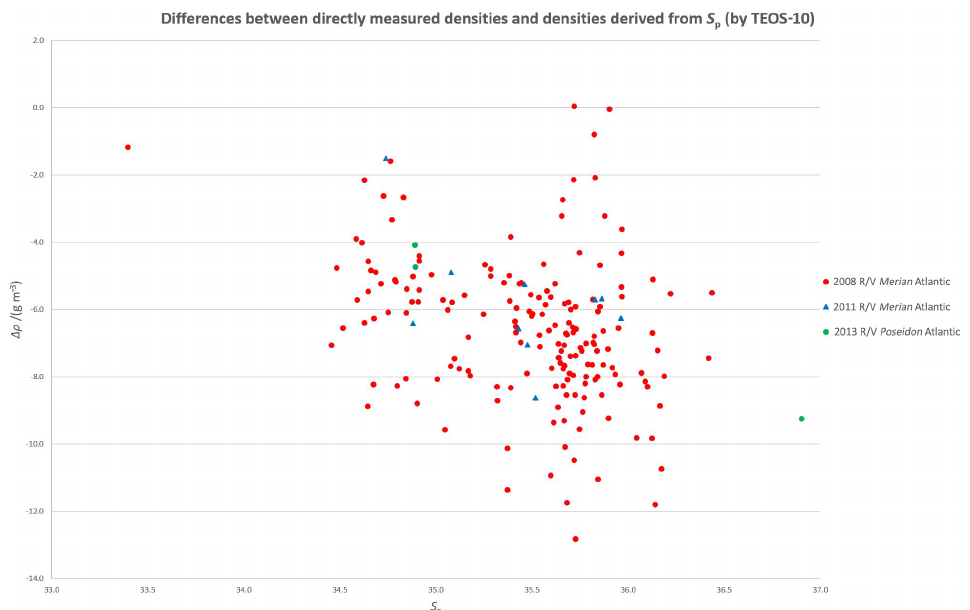
Figure 3. Example for differences between directly measured densities and values calculated from TEOS-10 with measured practical salin- ities, S P . Samples taken in 2008, 2011 and 2013 from eastern Atlantic surface waters between 33 ◦ N and 18 ◦ S show systematic negative density anomalies up to 13ppm (diagram courtesy Stefan Weinreben, IOW, personal communication,